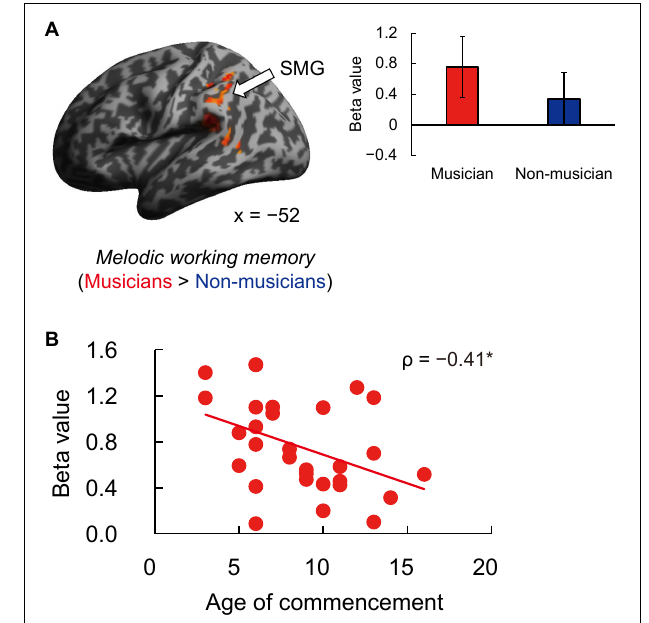
FIGURE 6 | Task-related brain activity. (A) Musicians exhibited increased activation of the left SMG during the MWM task (1-back vs. rest), whereas no change was seen in auditory and motor regions. (B) Using ROIs in the left SMG, age at commencement of musical training was negatively correlated with task-related SMG activation in musicians. * P < 0.05, SMG, supramarginal gyrus; MWM, melodic working memory; ROI, region of